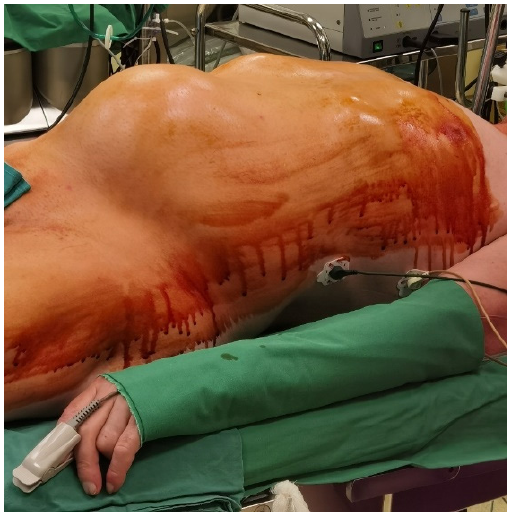
Figure 4. Image of the large abdominal palpable mass.